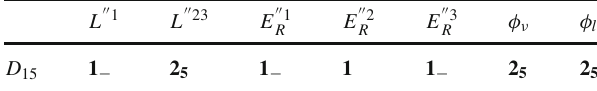
Table 6 Representations of the quarks under D 15 Table 7 Representations of the leptons under D